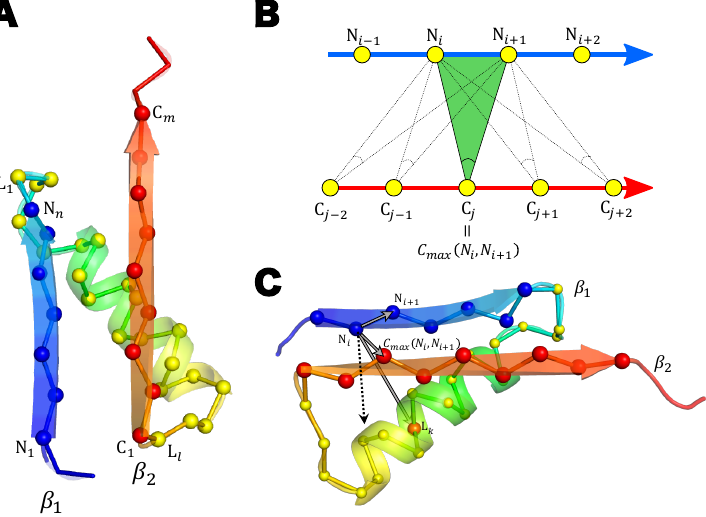
Figure 9. Calculation of the left-handedness score, L - score . ( A ) An example left-handed βαβ -unit. The cartoon representation and the backbone representation of the main chain are superposed. C α atoms are drawn with spheres in the backbone representation. The first and the last residue numbers of β 1, β 2, and the linker part are labeled on the chain. ( B ) Determination of C max ( N i , N i + 1 ) . ( C ) Calculation C α N C α C of a term in L - score . The vector connecting C α N , the one connecting C α N , and i i + 1 i max ( N i , N i + 1 ) C α L the one connecting C α N in Equation (7) are drawn with gray arrows and the vector product of i k the first two vectors are drawn with a dashed arrow. The calculated score of this example βαβ -unit is L - score =